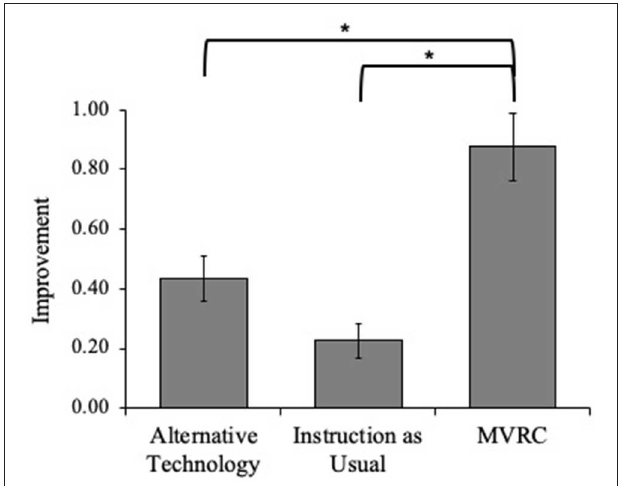
FIGURE 8 | Average improvement of 4th-grade reading fluency, as a function of condition. Error bars represent standard errors. *Significant difference obtained with Bonferroni pair-wise comparisons ( p <